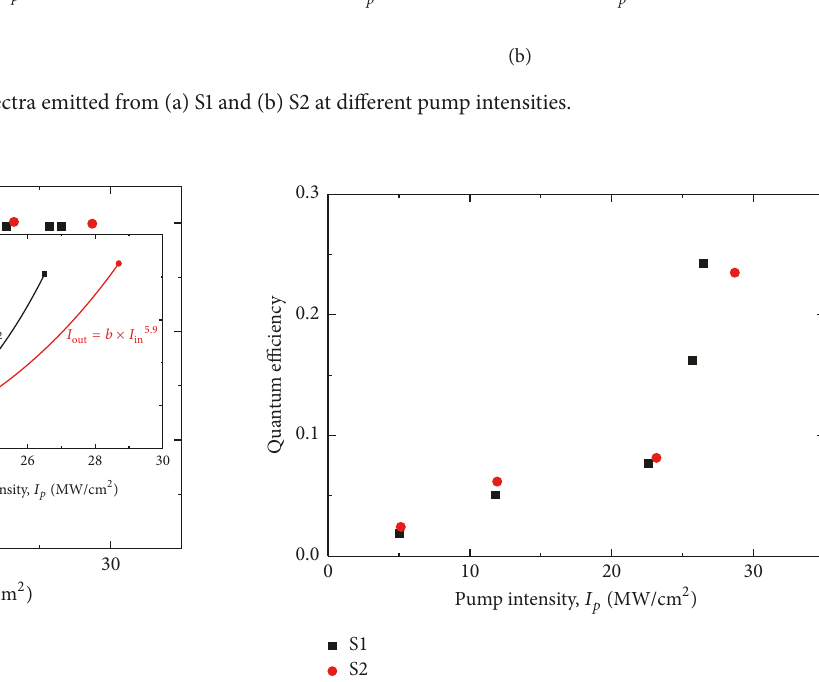
Figure 7: Peak emitted wavelength at different pump intensities for S1 and S2. Inset is the input-output intensity dependence in the stimulated emission region.